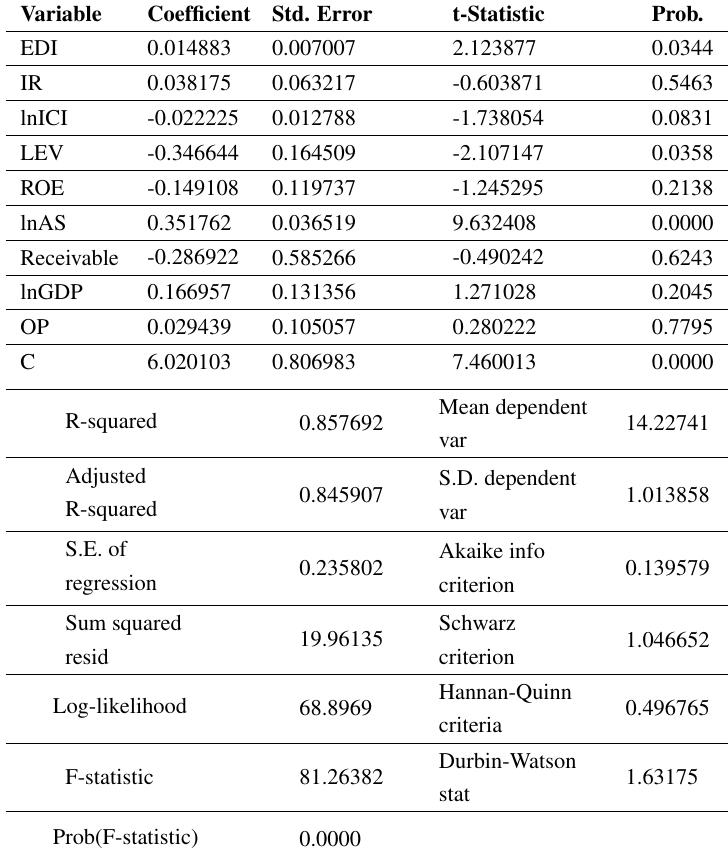
Table 6 The individual fixed effect model of the first